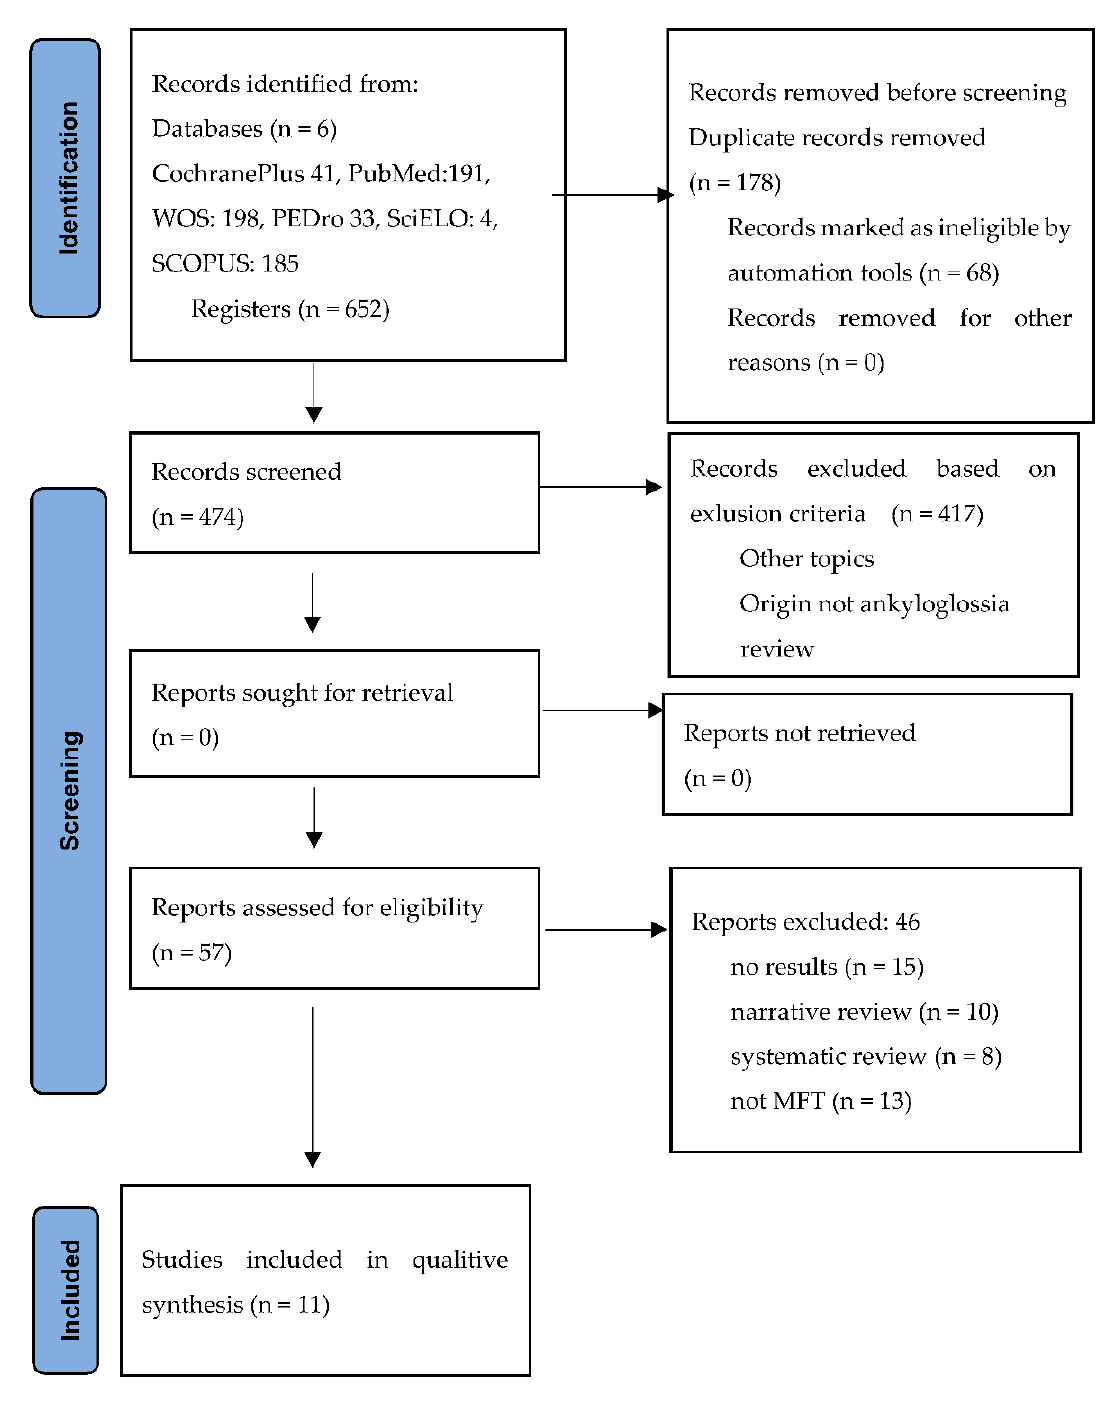
Figure 1. PRISMA 2020 flow diagram. From: Page MJ, McKenzie JE, Bossuyt PM, Boutron I, Hoffmann TC, Mulrow CD, et al. The PRISMA 2020 statement: an updated guideline for reporting systematic reviews. BMJ 2021;372: n71. doi: 10.1136/bmj.n71. For more information, visit: http://www.prisma-statement.org/ (accessed on 2 June 2022).